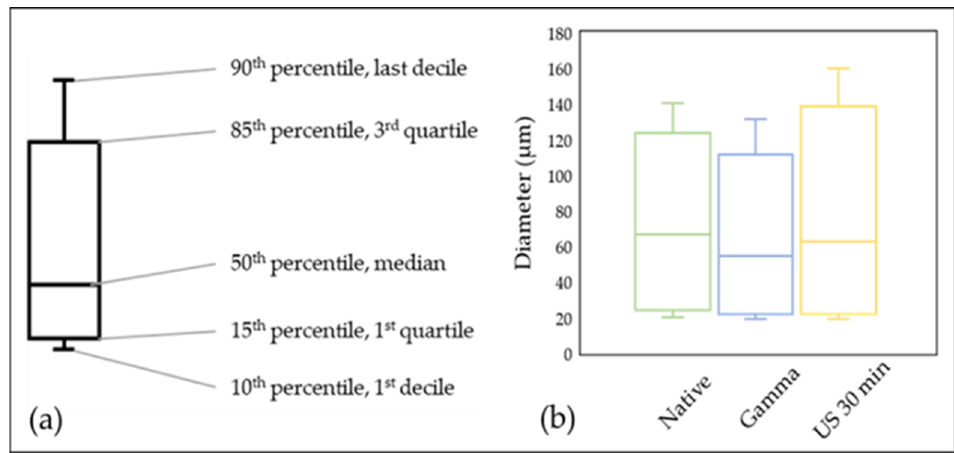
Figure 3. ( a ) Signification of a box-plot representation; ( b ) diameter distribution of native and pre-treated flax tows.